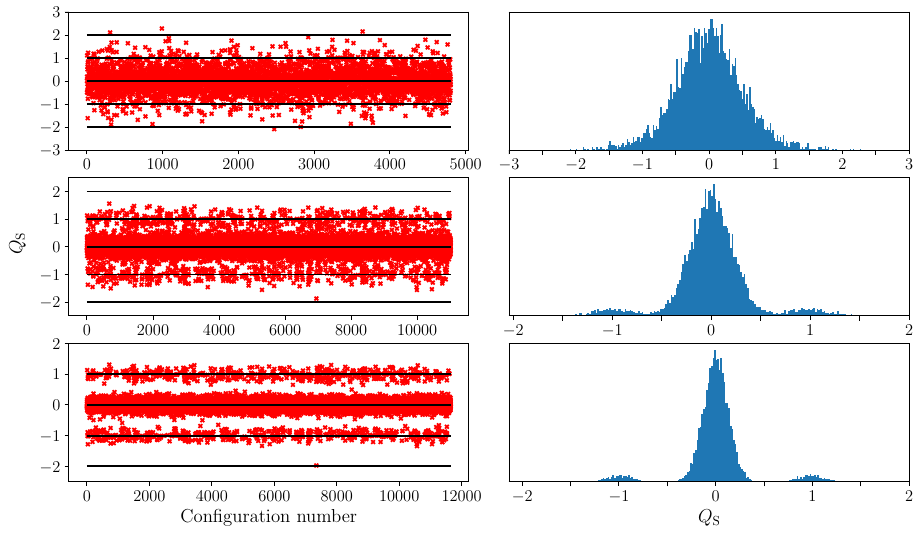
Figure 8 . Histograms of Q S for a lattice with 10 × 32 3 sites, at temperature T = 5 T c , and different gradient flow depths. The amount of flow corresponds to τ see that as we go down the flow path, the peaks are more defined. While for τ see the topological nature of the jumps, that becomes clear for τ criterion (4.3) fails for the top case, but is satisfied for the other